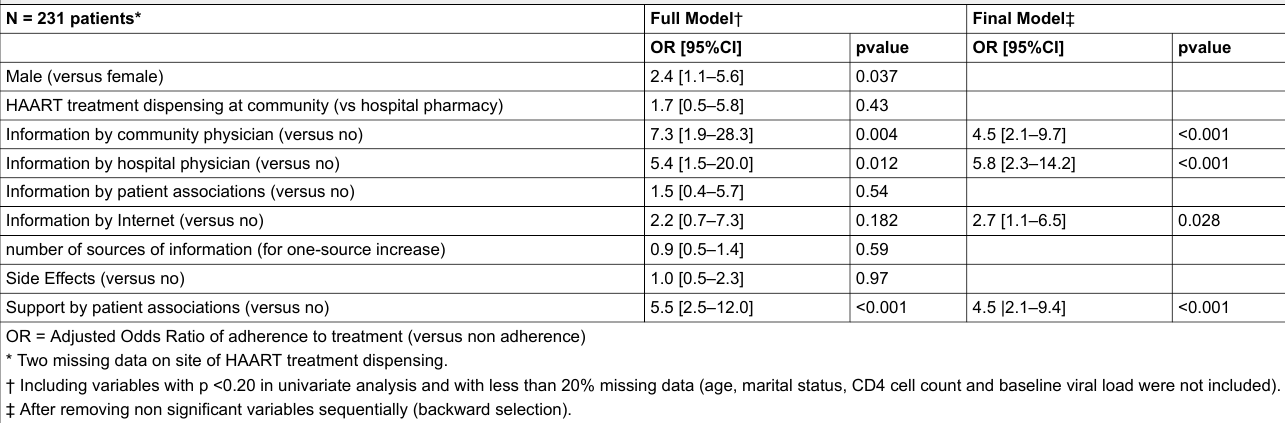
Table 4: Multivariable analysis of adherence to treatment. N = 231